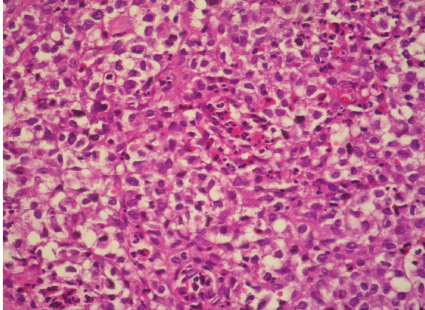
Figure 2: Neoplastic proliferation of Langerhans cells (hematoxylin and eosin staining × 200).